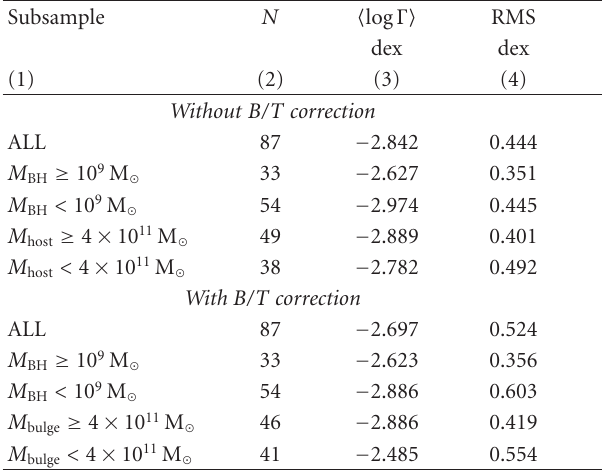
Table 4: Average values of the M BH /M host ratio in various subsets of our sample. (1) Subsample. (2) Number of objects. (3) Average value of log Γ . (4) Root Mean Square of log Γ